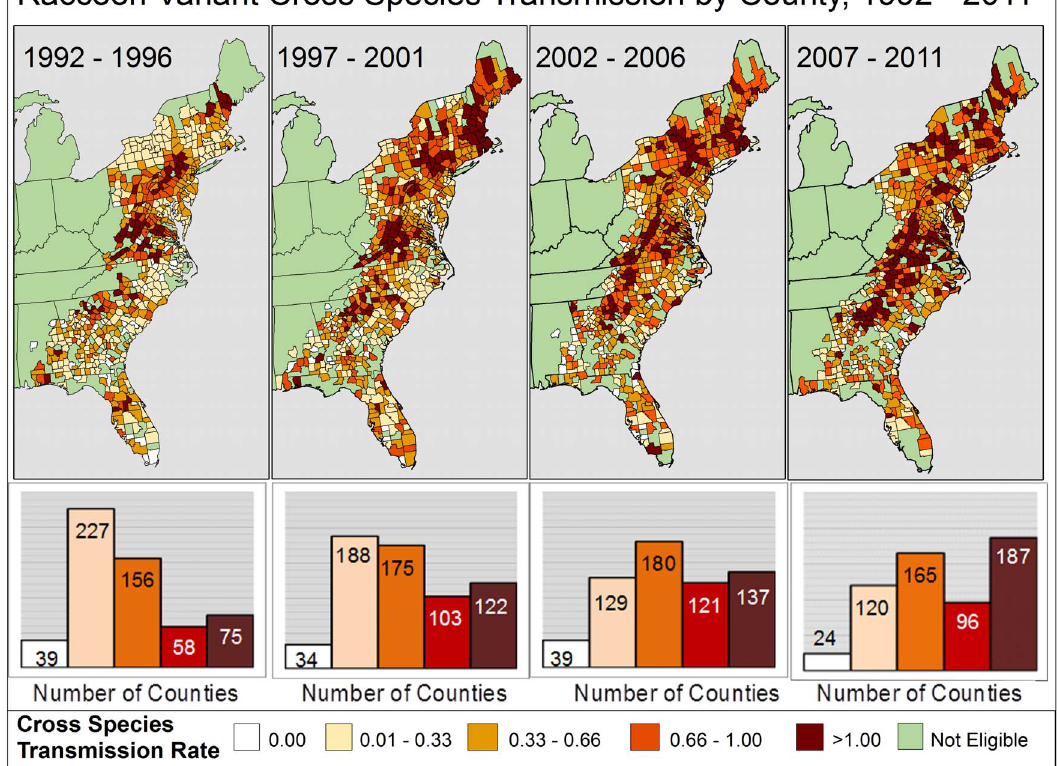
Figure 3. Five-year aggregate spillover rates of raccoon rabies virus variant, by County: 1992–2011.